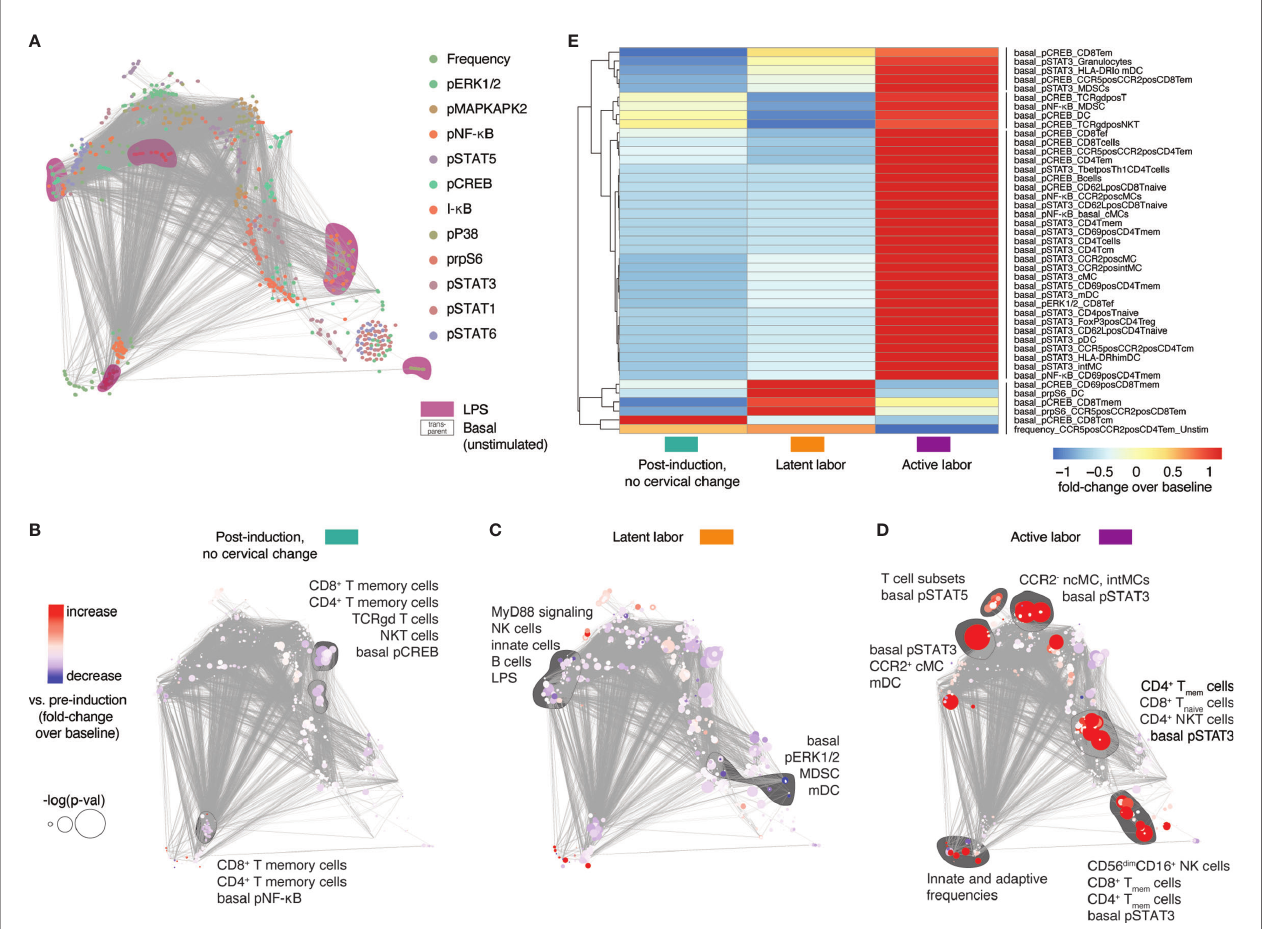
FIGURE 2 | Systemic immune responses in maternal blood after labor induction. (A) Correlation network showing the relationships between immune features within and across mass cytometry data categories. Features and communities are annotated based on stimulation condition, and functional marker. (B – D) Correlation networks depicting immune feature changes 1 hr post-induction (no cervical change since admission, T2, teal), in the latent phase of labor (T3, yellow), and with active labor (T5, purple), compared to baseline (pre-induction) (T1). Node color indicates increase/decrease (red/blue) compared to baseline (T1). Node size represents p-value (adjusted for multiple comparisons) associated with paired (B) and unpaired (C, D) T tests compared to baseline (univariate comparisons). (E) Heatmap showing Z-scored fold change feature behavior across time points [post-induction (T2, teal), in the latent phase of labor (T3, yellow), and with active labor (T5, purple)] compared to baseline (T1). Shown are features signi fi cantly different from baseline (p < 0.05, Wilcoxon signed-rank test for T1 vs. T2 or rank-sum test for T1 vs. T3-5). See also Supplementary Figure 1 and Supplementary Table 2